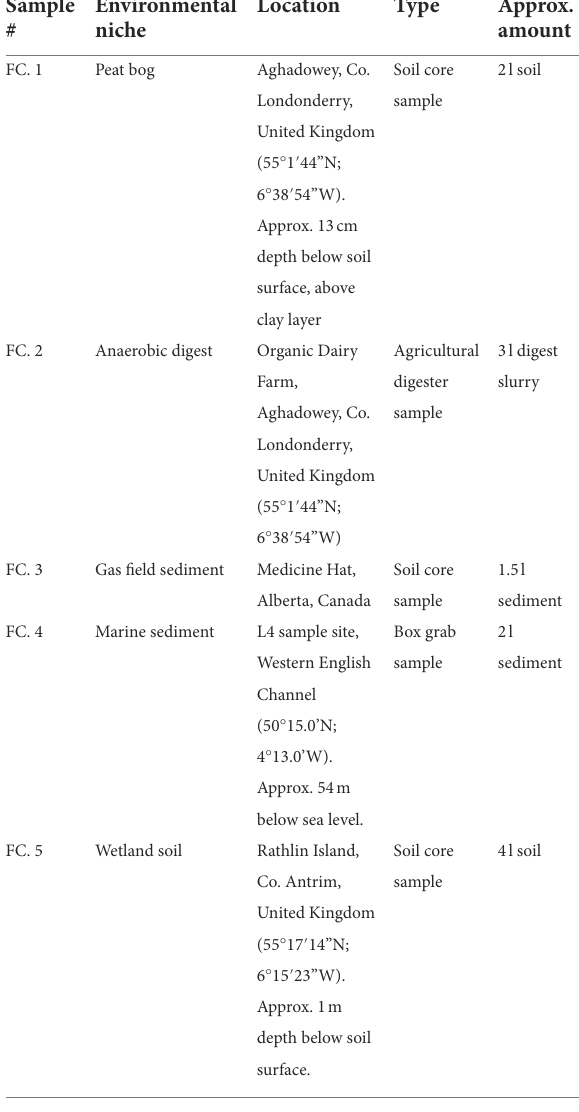
TABLE 1 Samples were collected from 5 sites where environmental conditions were thought to be promising for microbial propane